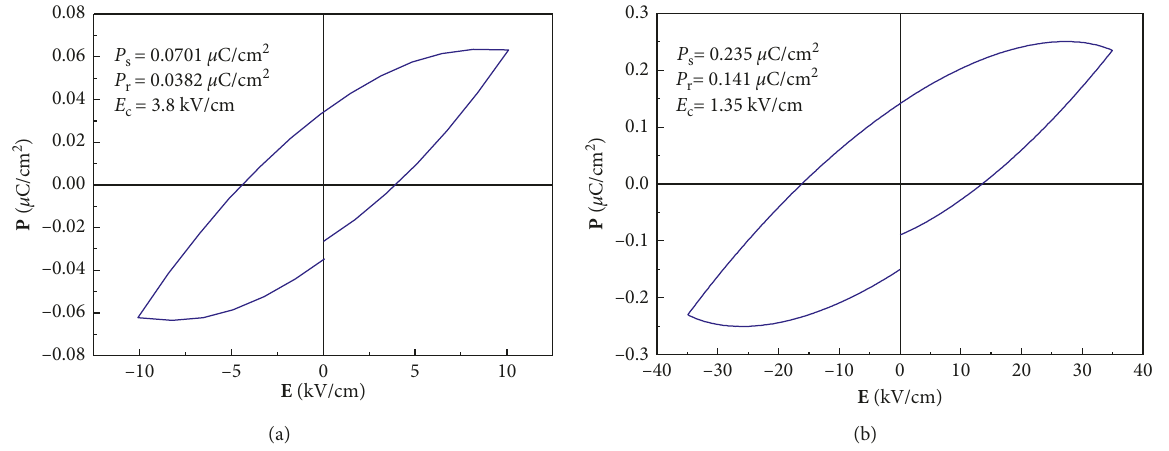
Figure 5: Multiferroic properties; ferroelectrical hysteresis loop: (a) LiNbO